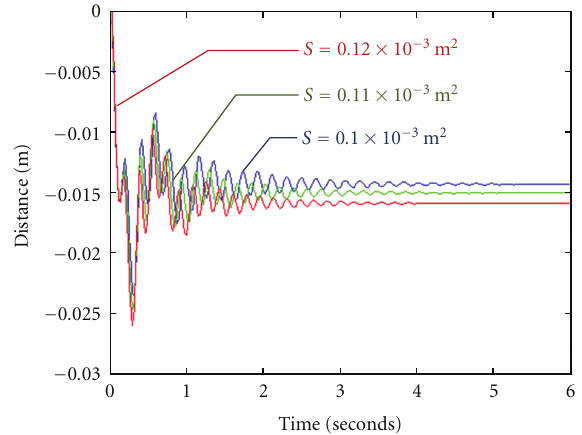
Figure 12: Dragonfly flapping straight—changing the weight. Velocity versus time.